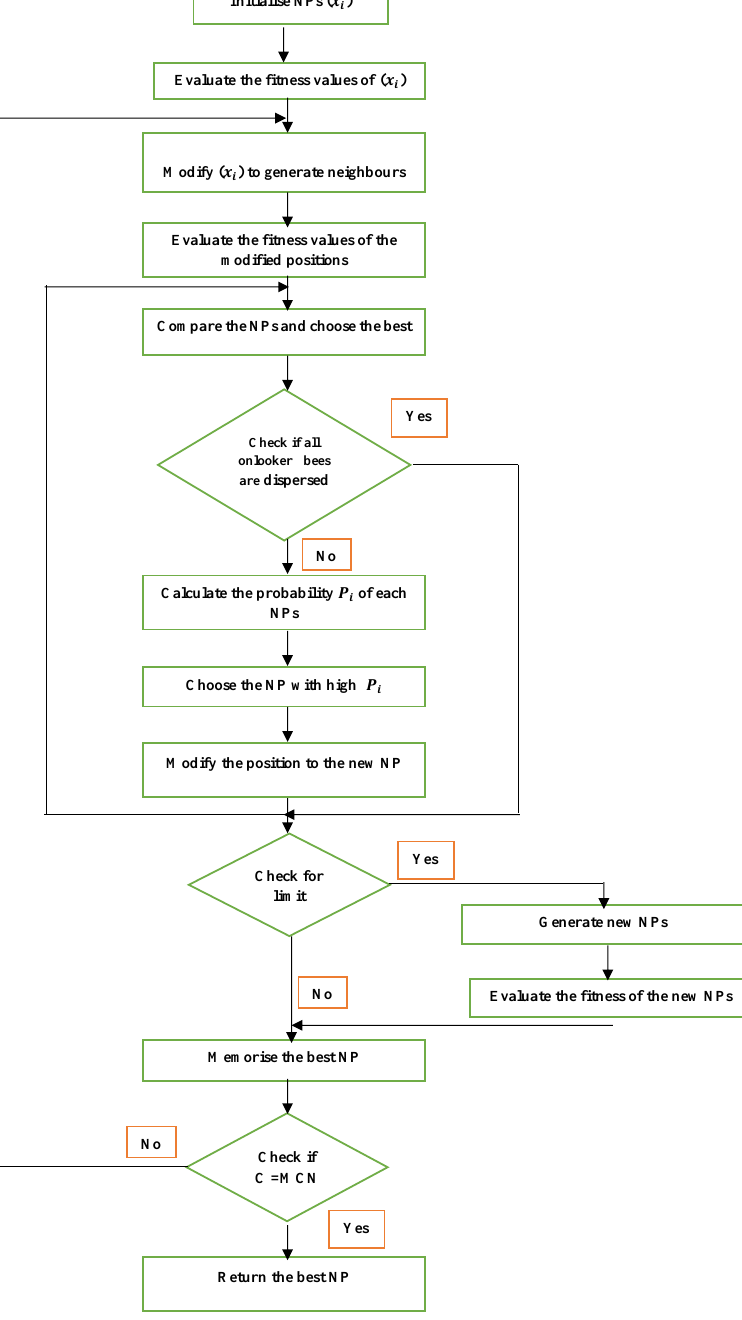
Figure 9. Flowchart of ABC optimization